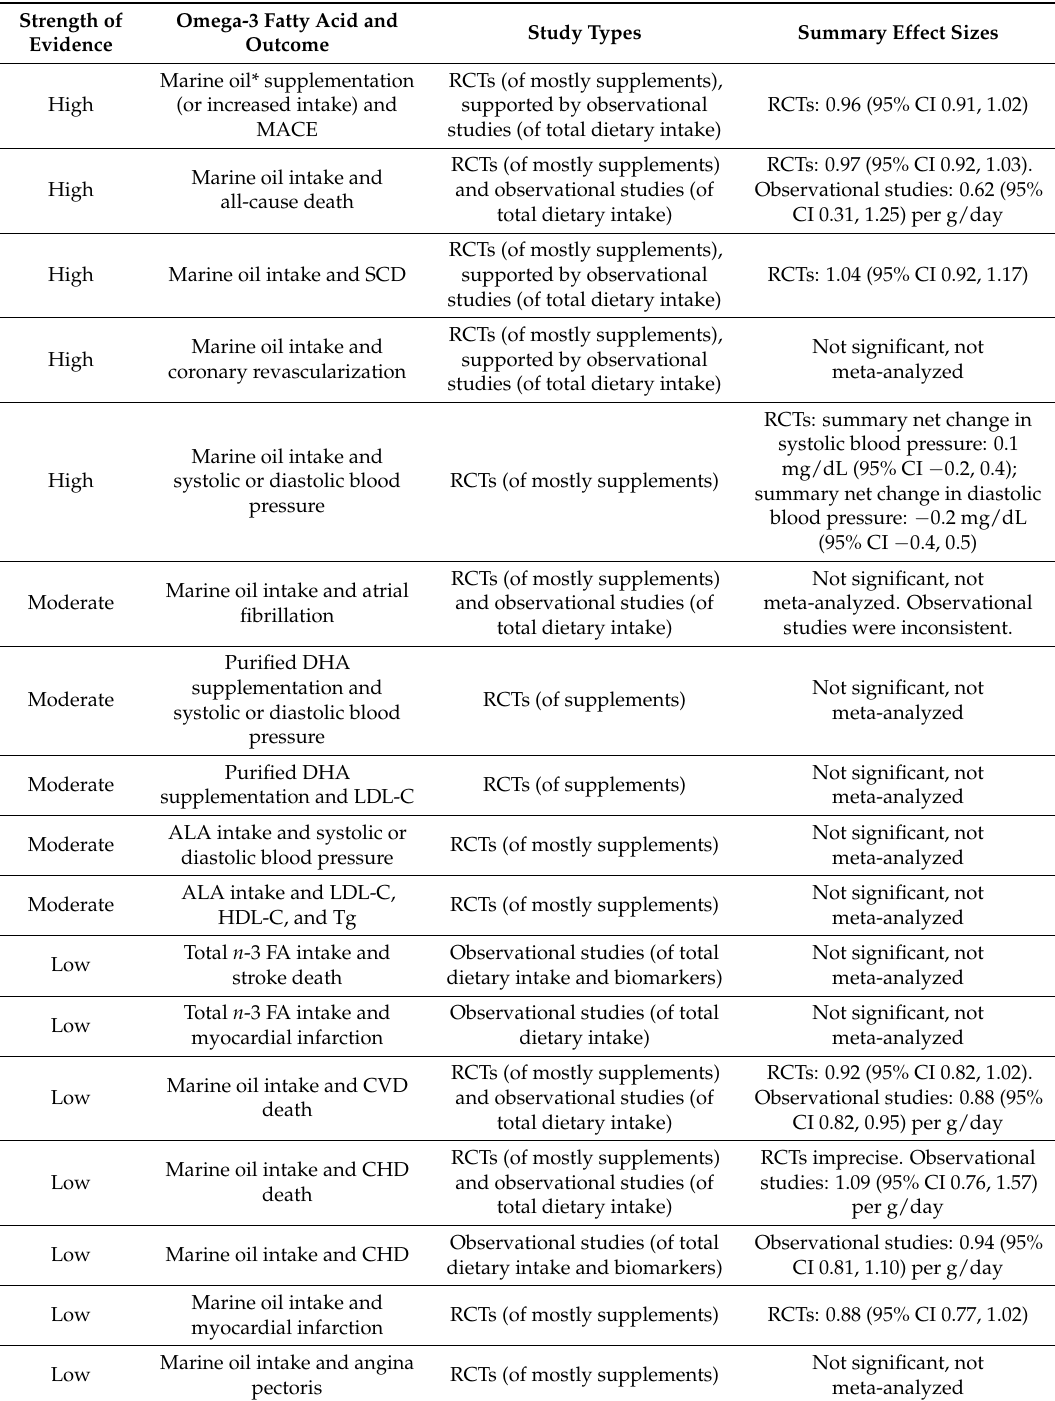
Table 3. Main findings of high, moderate, or low strength of evidence of no significant effects or associations between omega-3 fatty acids and